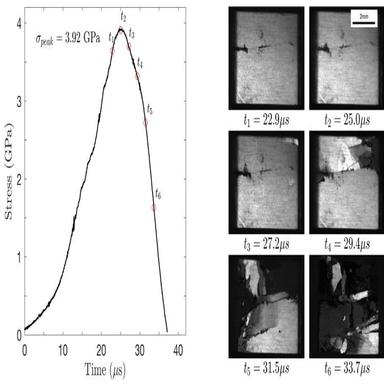
Stress-time history of dynamic uniaxial compression of pristine boron carbide with time resolved high speed video images .